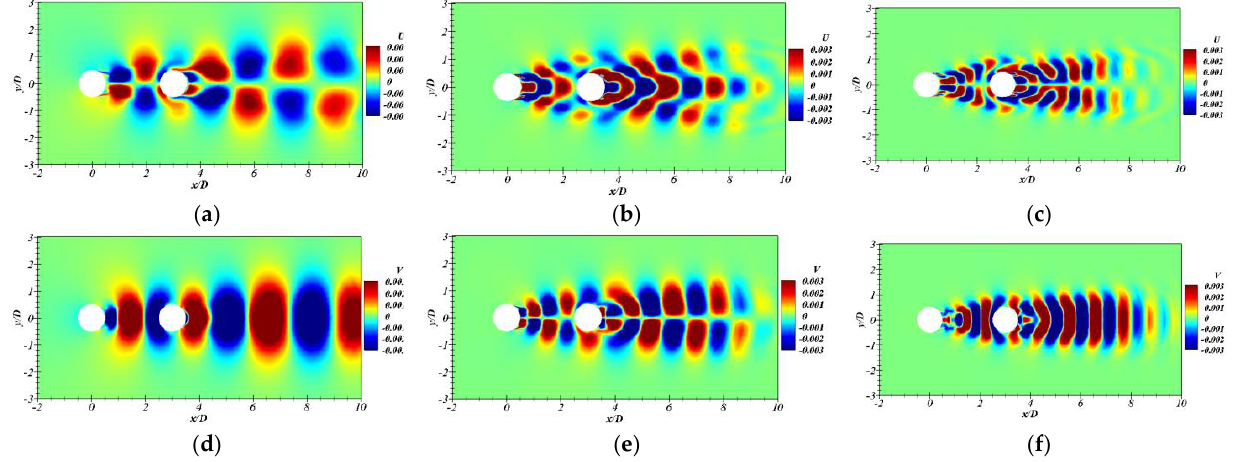
Figure 18. Spatial structures of velocities for 𝐿/𝐷 = 3 : the streamwise velocity for ( a ) Mode 1; ( b ) Mode 2; ( c ) Mode 3 and the cross-flow velocity for ( d ) Mode 1; ( e ) Mode 2; ( f ) Mode 3.